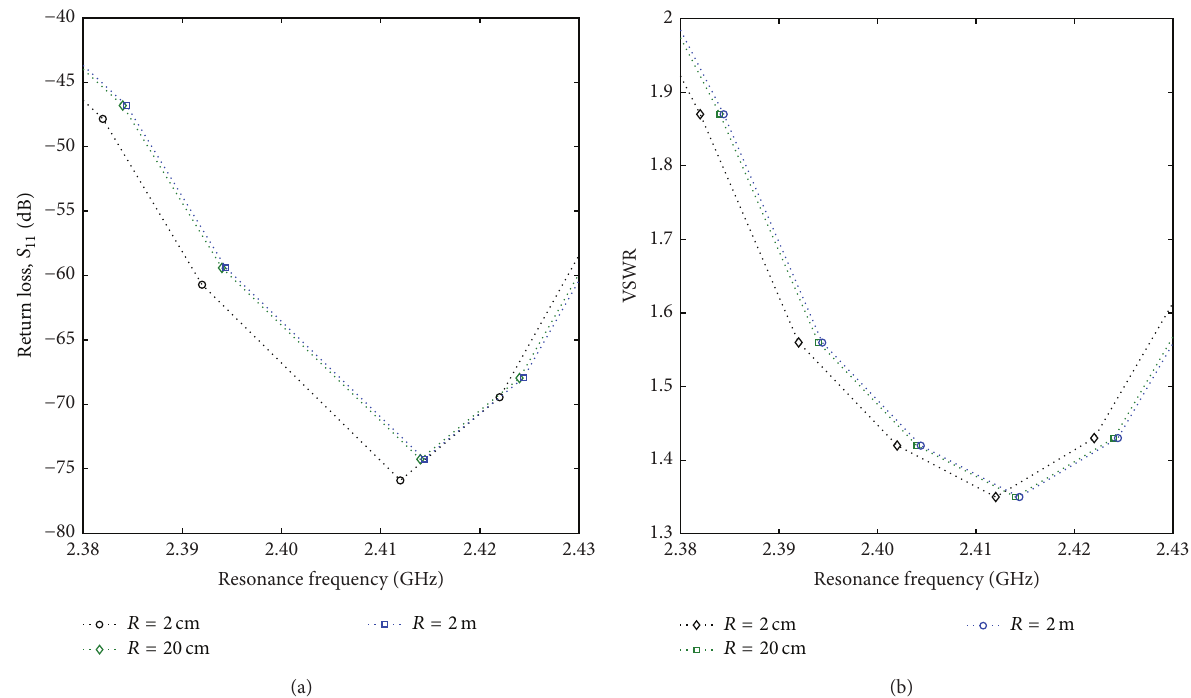
Figure 9: Impact of changing radius of curvature (2cm, 20 cm, and 2 m) of a circular microstrip patch (a) on the return loss in dB and (b) on the VSWR as a function of frequency. “Epsilam-10 ceramic-filled Teflon substrate,